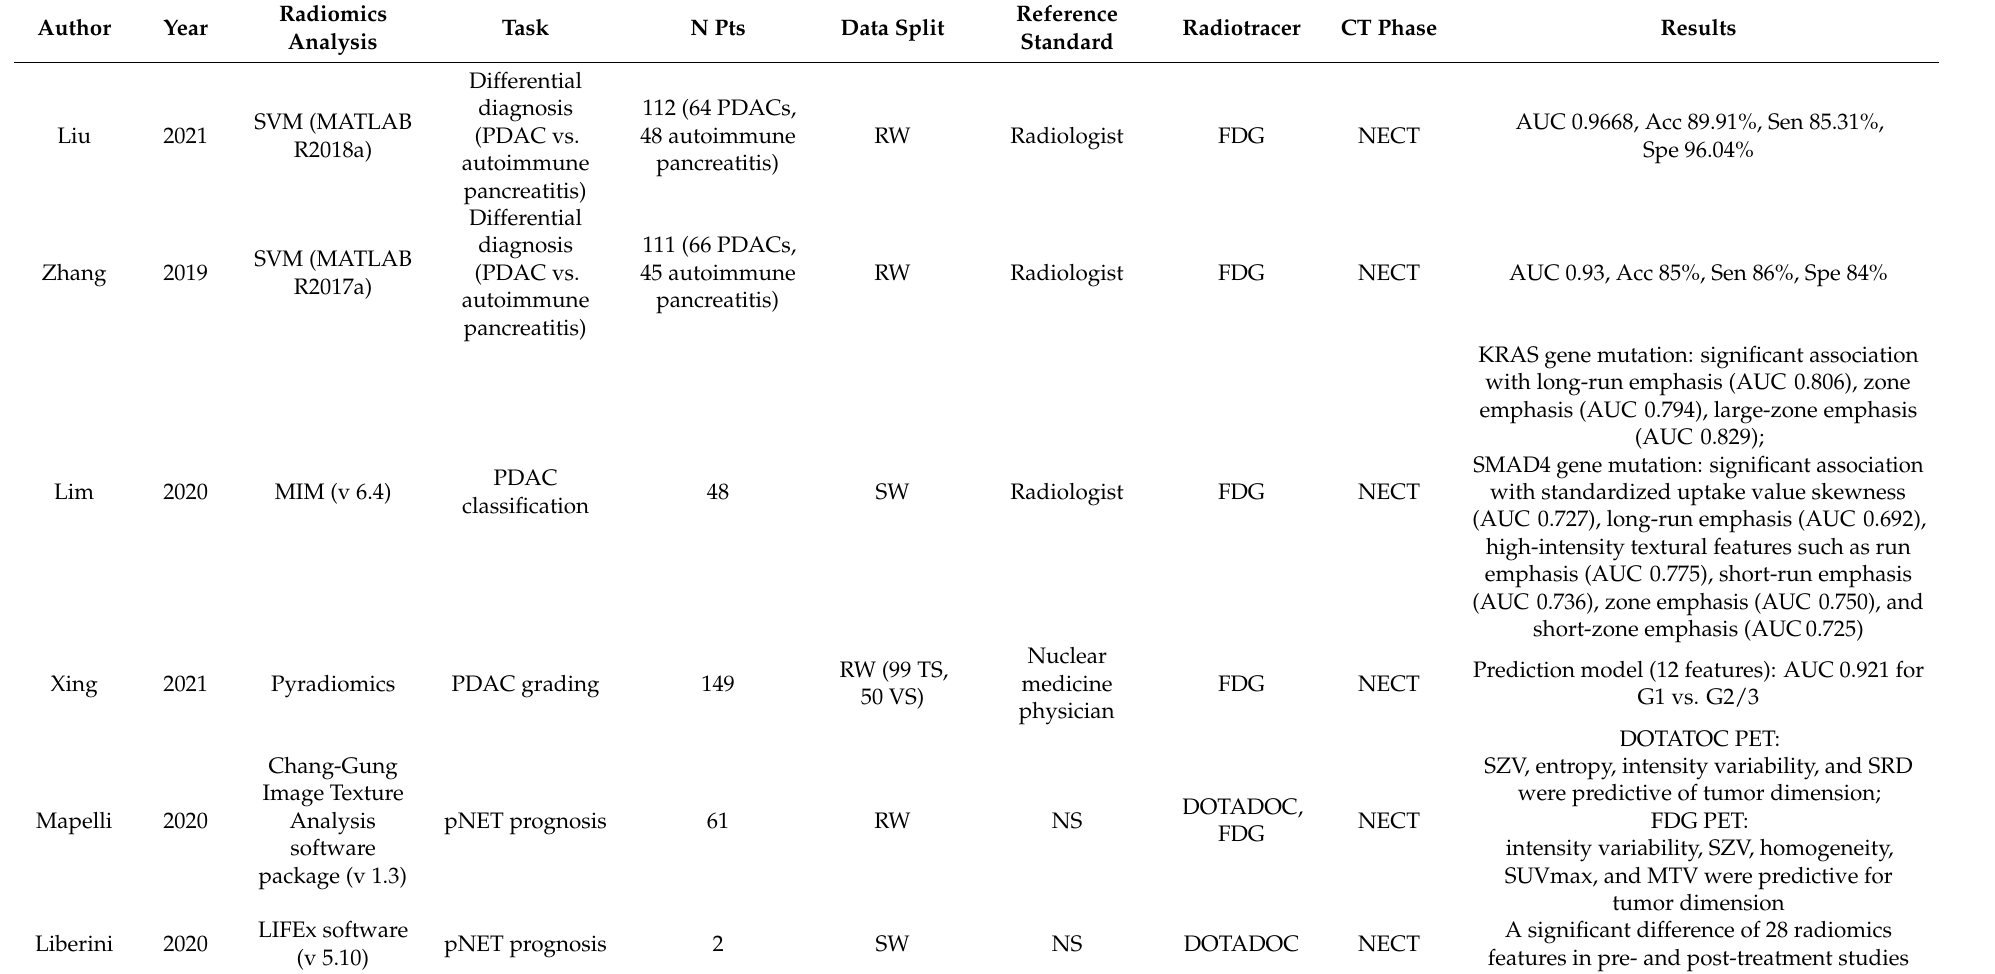
Table 2. Applications of radiomics in pancreatic PET-CT